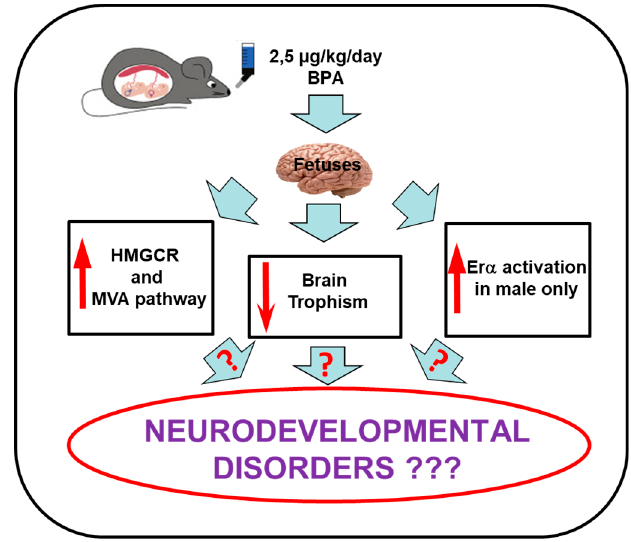
Figure 9. Graphical model summarizing principal results.